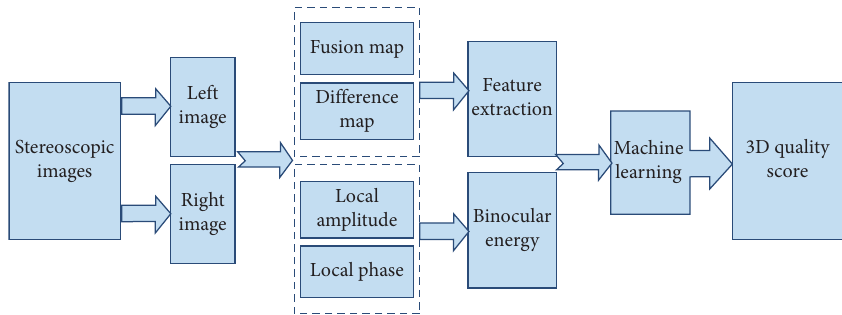
Figure 2: The architecture of our proposed quality assessment scheme for stereoscopic images.